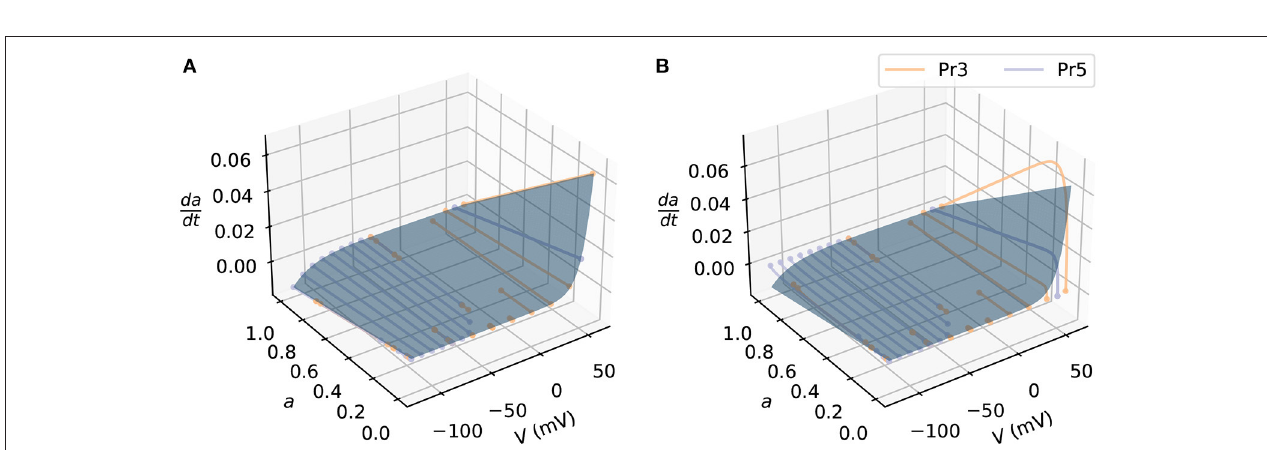
FIGURE 2 | An example of the state space simulated in synthetic data studies. The state space of the candidate model (blue surface) is shown as blue surfaces. The simulated activation steady-state protocol (Pr3, orange lines) and the simulated deactivation time constant protocol (Pr5, purple lines) are shown for (A) the candidate model and (B) the ground truth model. Each dot at the two ends of the lines indicates a voltage step jump in the protocols.